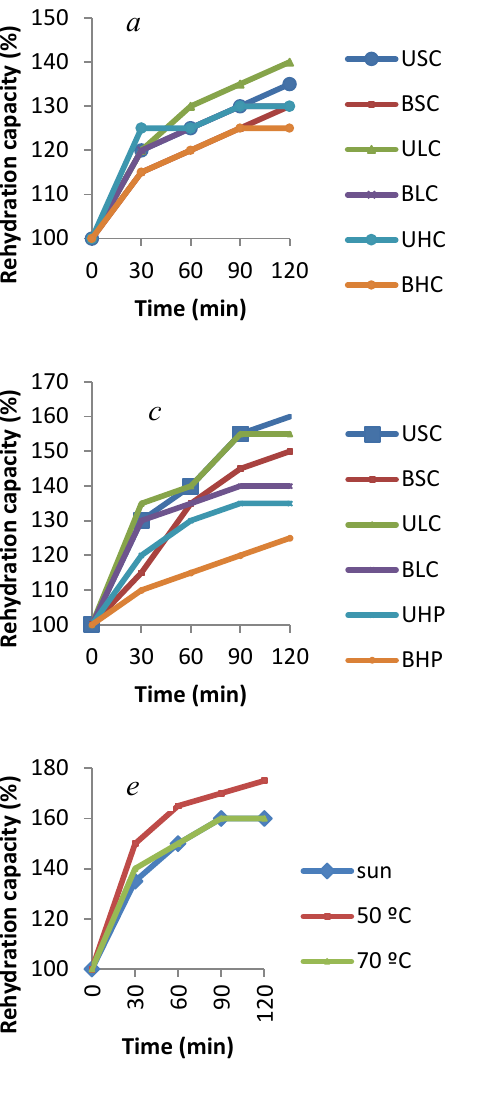
Figure 7: Rehydration capacity of: Figure 5: Rehydration capacity of: a. Cardaba slices rehydrated at room temperature; b. Cardaba slices rehydrated at 45°C; c. Cardaba slices rehydrated at 75°C; d. Cardaba slices rehydrated at 90°C; e. Blanched plantain rehydrated at 90°C; f. Unblanched cardaba rehydrated at